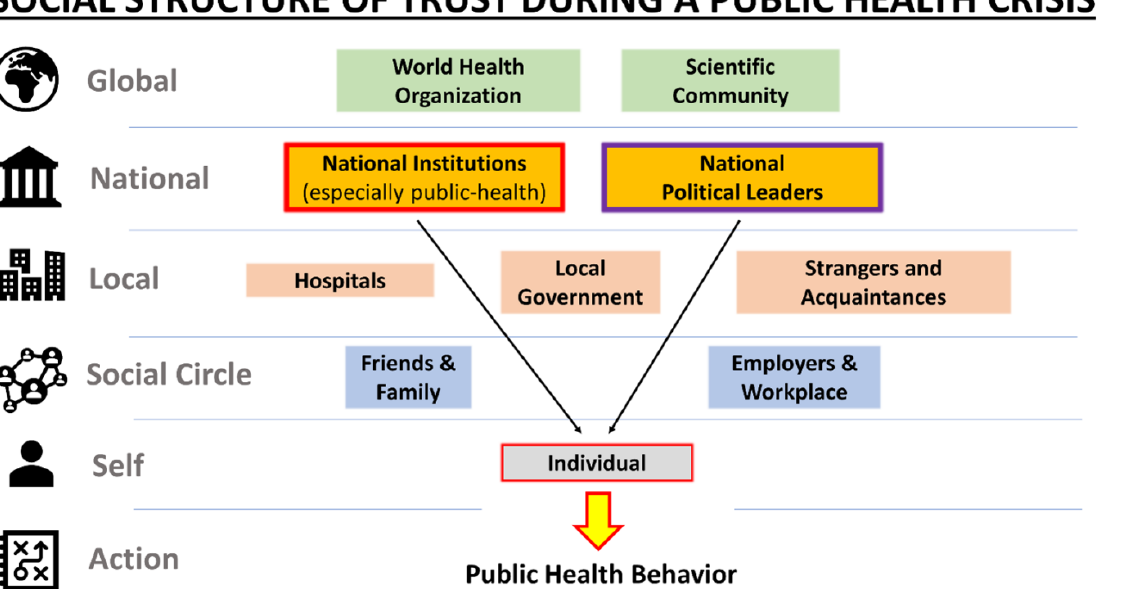
Table 1. Linear regression summary of the impact of trust variables on public health measure com- pliance (masks and social distancing) and belief in effectiveness of health measures *.